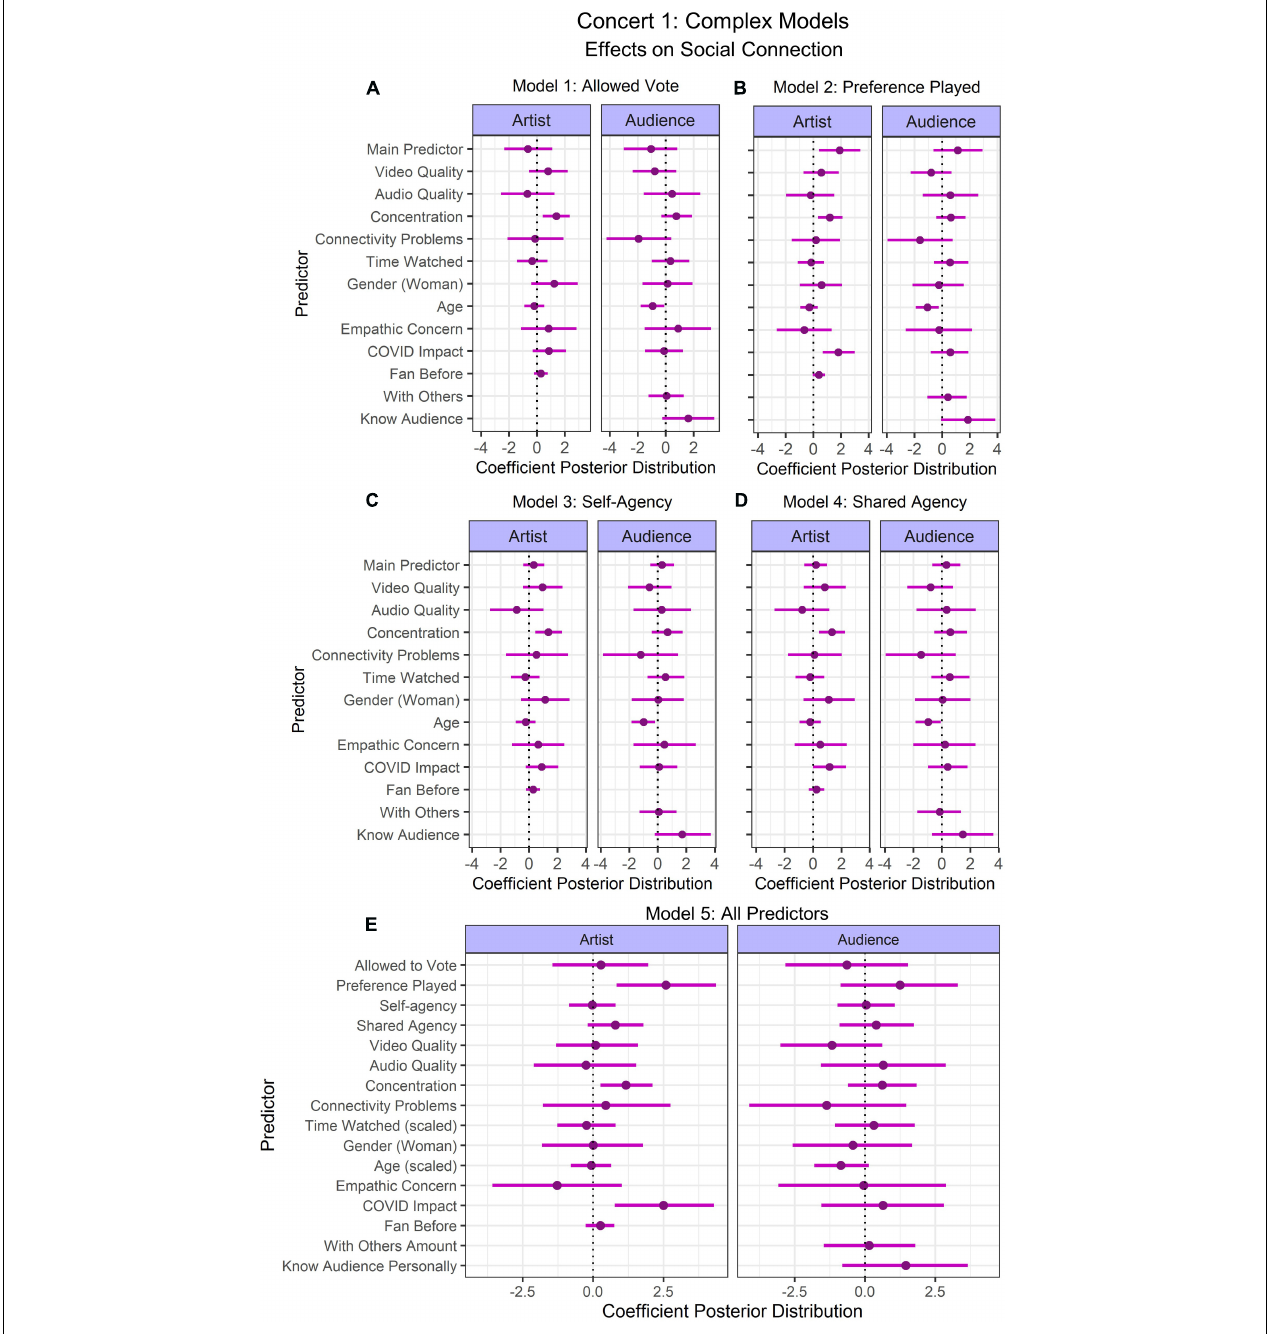
FIGURE 4 | Concert 1’s complex models’ predictor coefficient estimates (points) and 90% credible intervals (lines) for the effects on social connection to the artist (left) and audience (right). Five models were fit to examine the individual contributions of (A) Allowed to Vote, (B) Preference Played, (C) Self-agency, (D) Shared Agency, and one model was fit to examine all predictors (E)